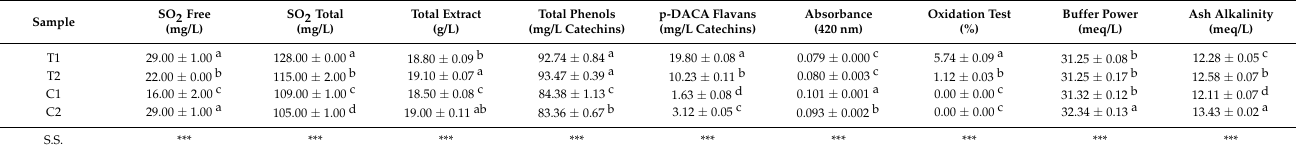
Result indicate mean value ± standard deviation of three determinations. Abbreviations: S.S., statistical signifi- cance; T1, sequential inoculum with M. pulcherrima MP346/ S. cerevisiae SPF52; T2, glutathione-rich inactivated yeasts and sequential inoculum with M. pulcherrima MP346/ S. cerevisiae SPF52; C1, single inoculum with S. cerevisiae SPF52; C2, glutathione-rich inactivated yeasts and single inoculum with S. cerevisiae SPF52. Data in the same column followed by the same letter are not significantly different according to Tukey’s test. p value: ***, p <